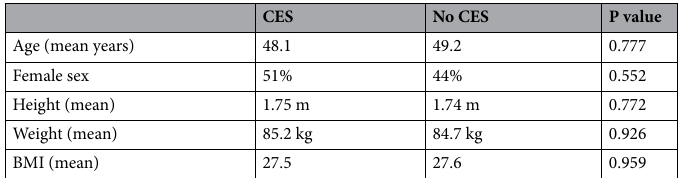
Table 2. Case–control data to compare the population with cauda equina syndrome (CES) to an age-adjusted cohort of patients undergoing spinal surgery for other degenerative spinal